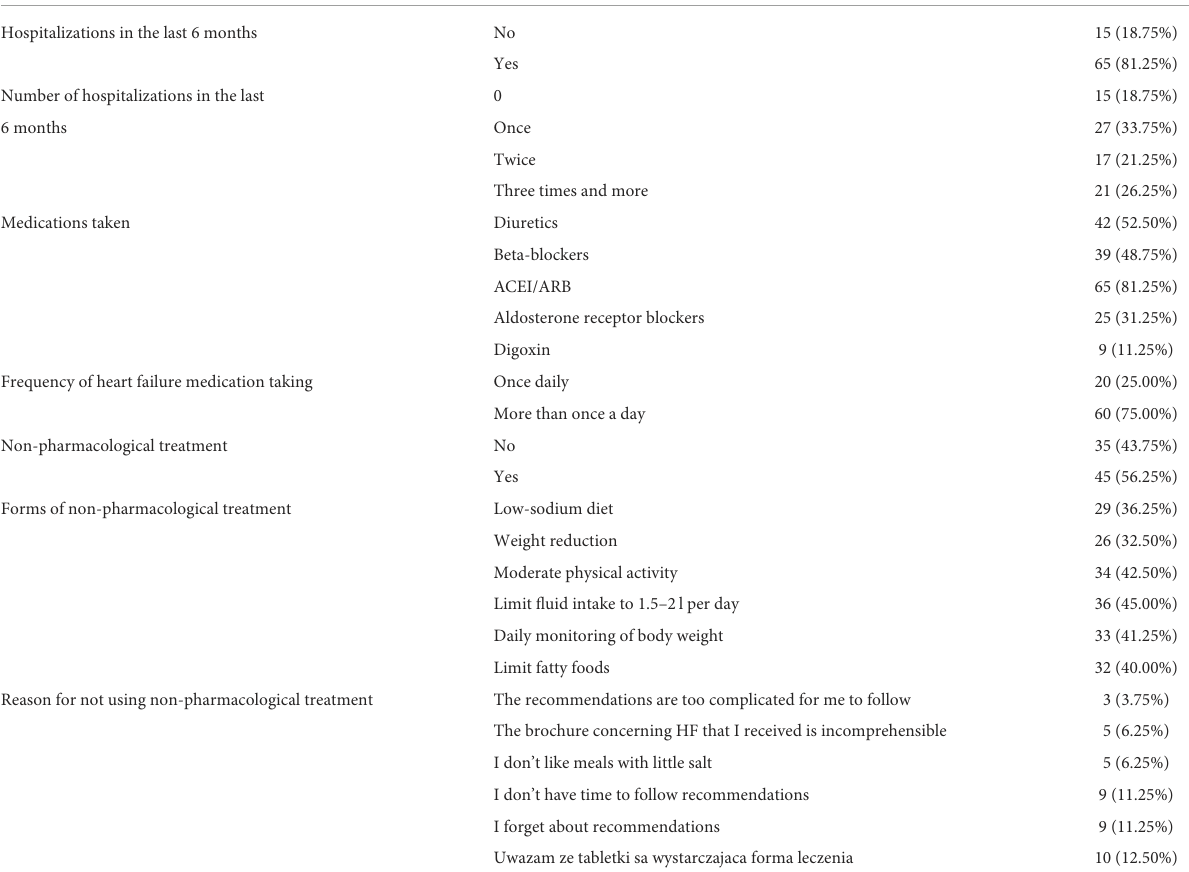
TABLE 3 Characteristics of the treatment used among the study group ( N =